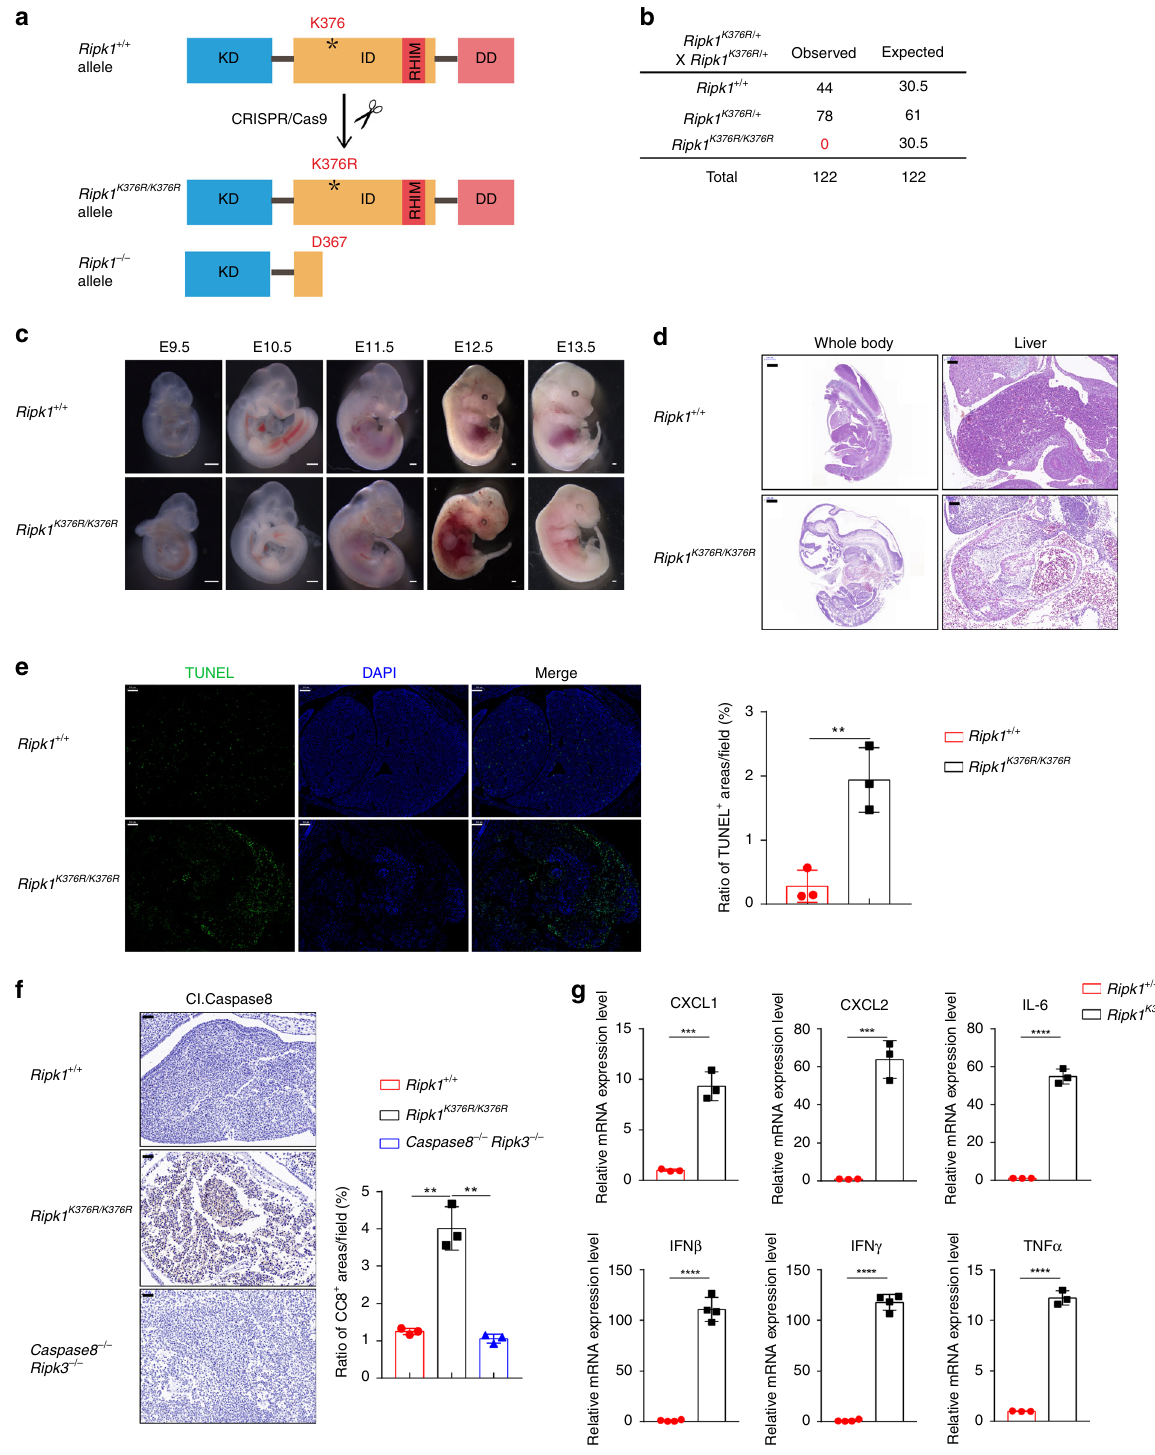
Fig. 1 Ripk1 K376R/K376R mutation results in embryonic lethality. a Schematic overview of strategy to generate Ripk1 K376R/K376R and Ripk1 − / − mice by CRISPR- Cas9 technology. KD, kinase domain; ID, intermediate domain; DD, death domain; RHIM, RIP homotypic interaction motif. b Statistical analysis of the expected and observed offspring mice (1-month-old) from the intercrosses of Ripk1 K376R/ + mice. c The representative images of embryos with the indicated genotypes from E9.5 to E13.5 (scale bar, 1 μ m). d Hematoxylin and eosin (H&E) staining of embryos (left, scale bar, 500 μ m) and liver sections (right,